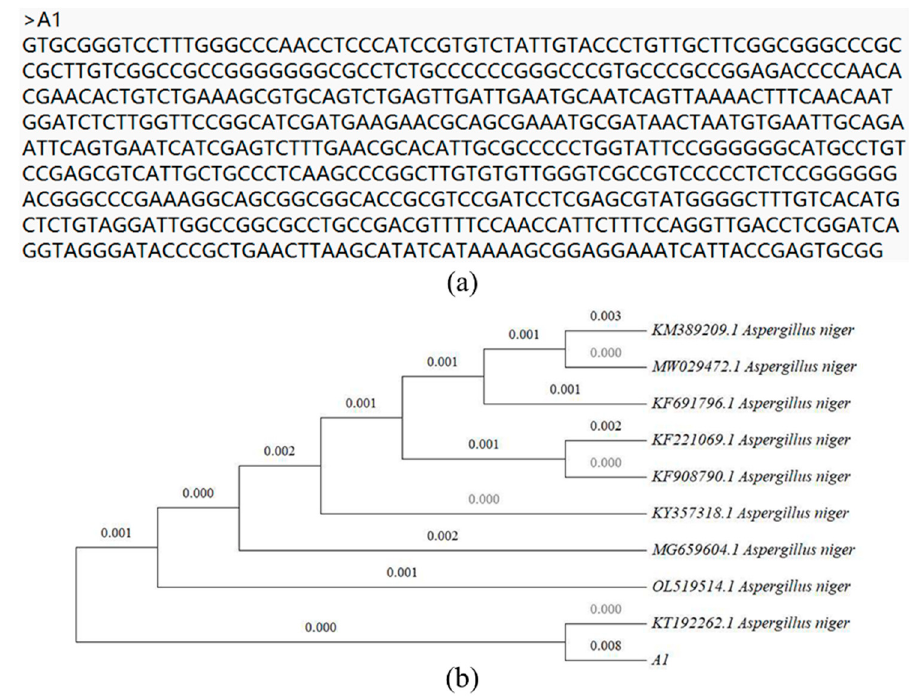
Figure 1. ( a ) Sequencing result of A1. ( b ) Phylogenetic tree of A1. Table 1. Screening of chromium tolerance of A. niger strains.